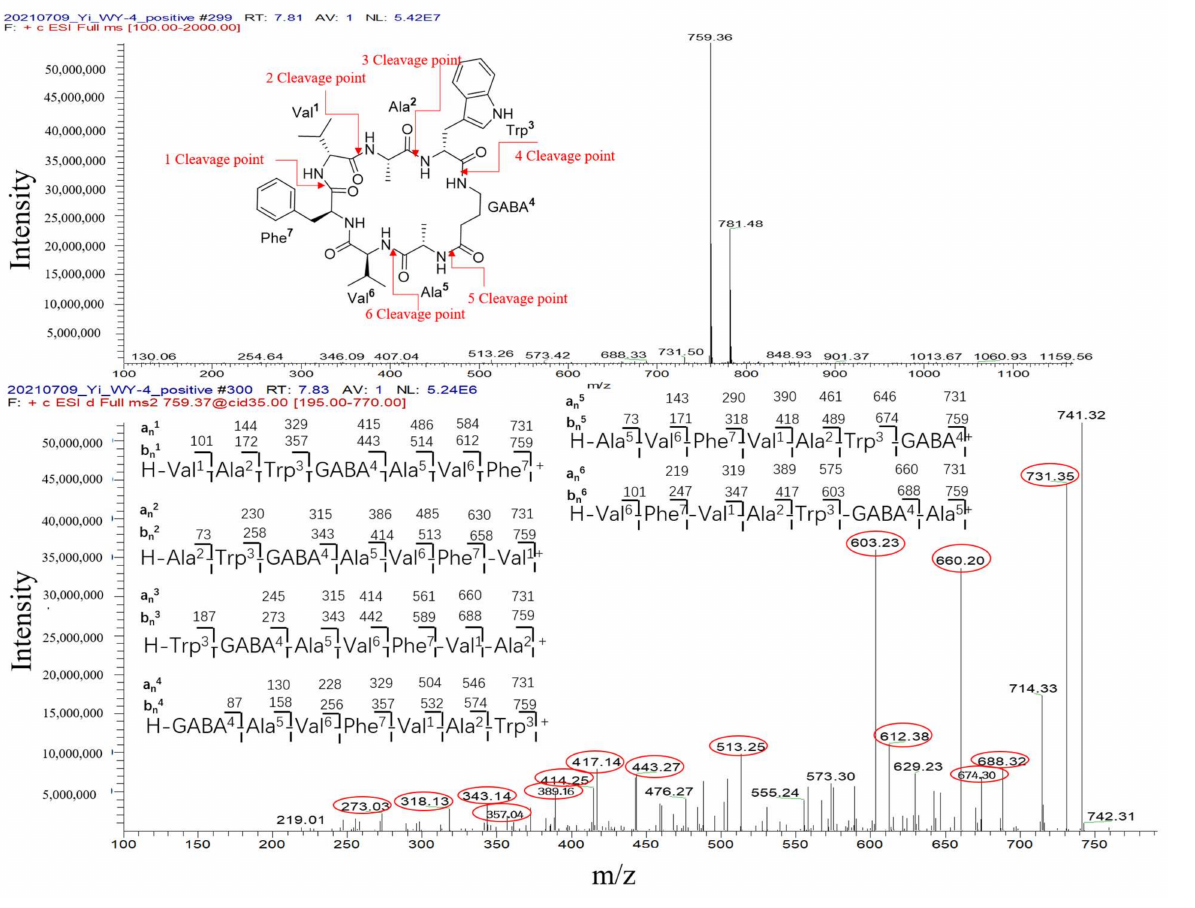
Figure 11. The interpretation of MS/MS spectrum of peak 4 (cyclopeptide unguisin